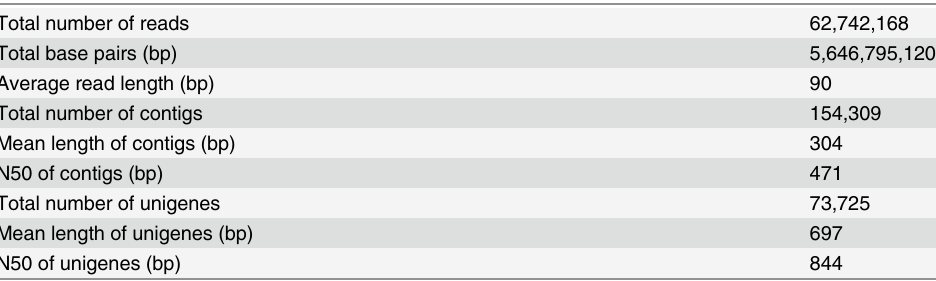
Table 1. Summary for the A . mongolicus leaf unigenes.